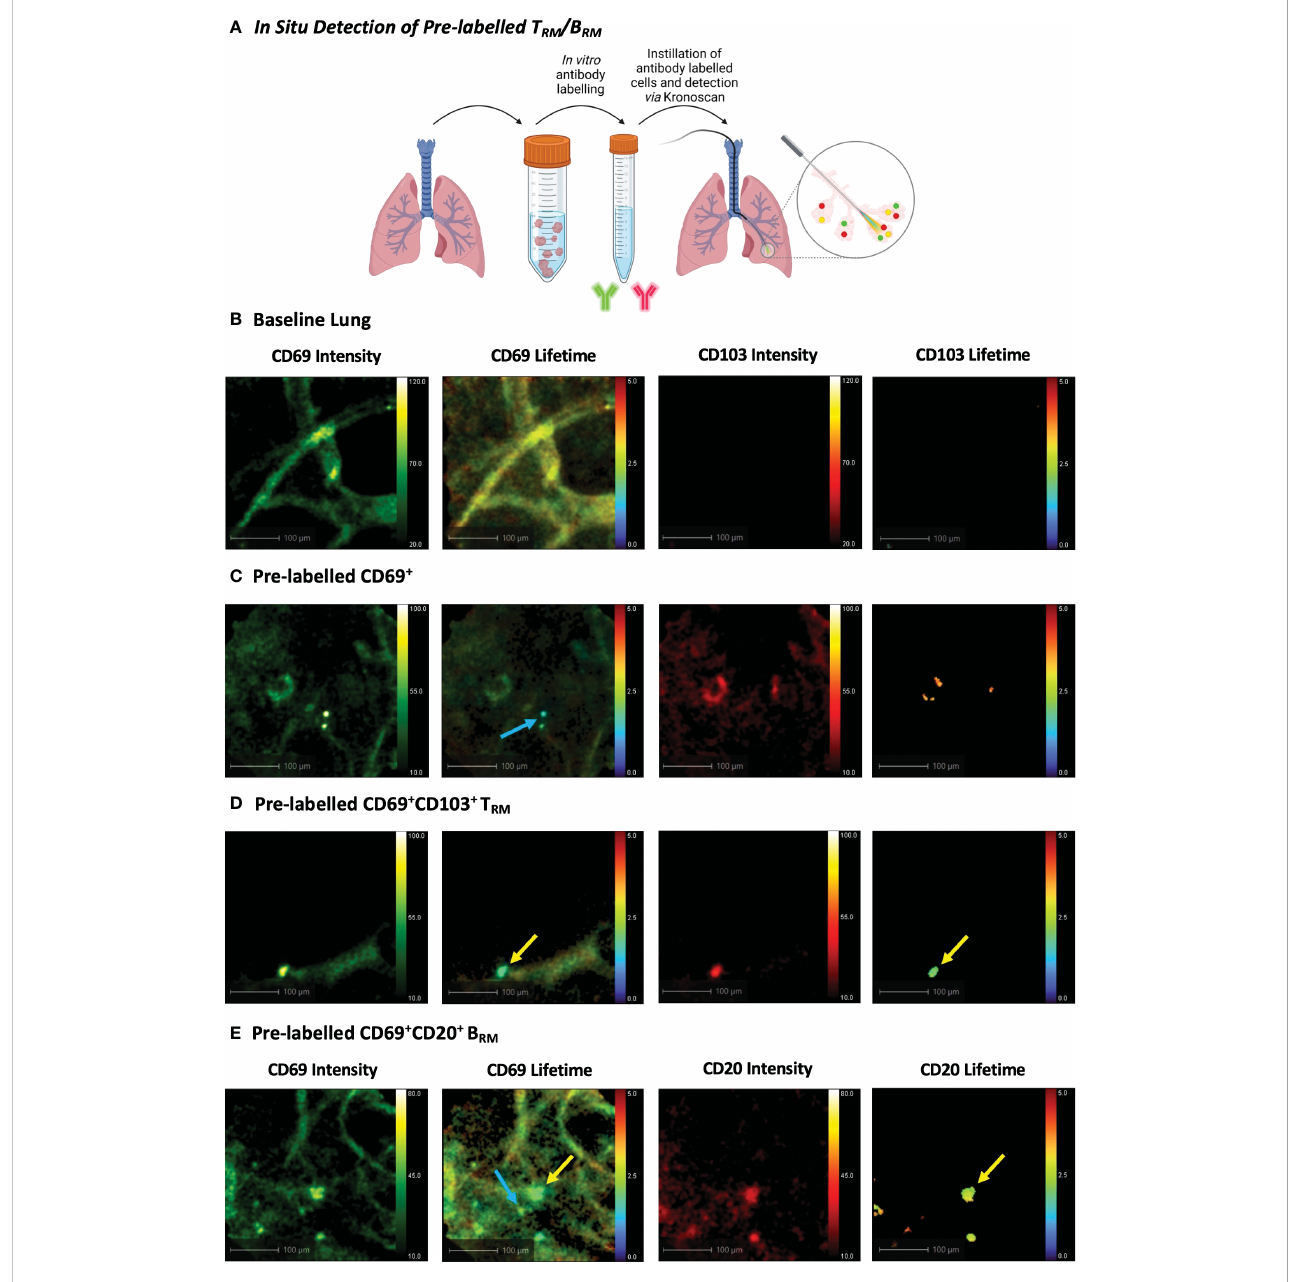
FIGURE 5 In Situ Detection of Pre-labelled T RM /B RM in Human Lung . (A) Pre-labelled human pulmonary T RM and B RM in suspension were instilled into the alveolar space and detected using KronoScan and Panoptes during human EVLV. (B) Baseline lung imaging prior to pre-labelled cell instillation. (C) In situ imaging of pre-labelled CD69 + cells. Lung tissue digest cells were stained with fl uorescent CD69 and CD103 antibodies prior to instillation into the alveolar space using Panoptes. Cells were imaged with KronoScan. Blue arrow indicates CD69 + cells. (D) In situ imaging of pre-labelled CD69 + CD103 + T RM . Yellow arrow indicates CD69 + CD103 + T RM . (E) In situ imaging of pre-labelled B RM . Lung tissue digest cells were stained with fl uorescent CD20 and CD69 antibodies prior to instillation to the alveolar space. Blue arrow indicates CD69 + cells and yellow arrow points CD69 + CD20 + B RM . Representative images from n=3